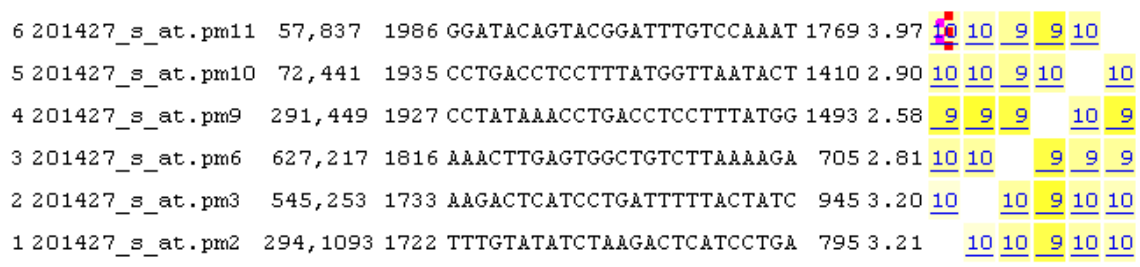
Figure 4. Highly correlated antisense probes from probeset 201427_s_at. The probes map in antisense direction to exon ENSE00001435187.